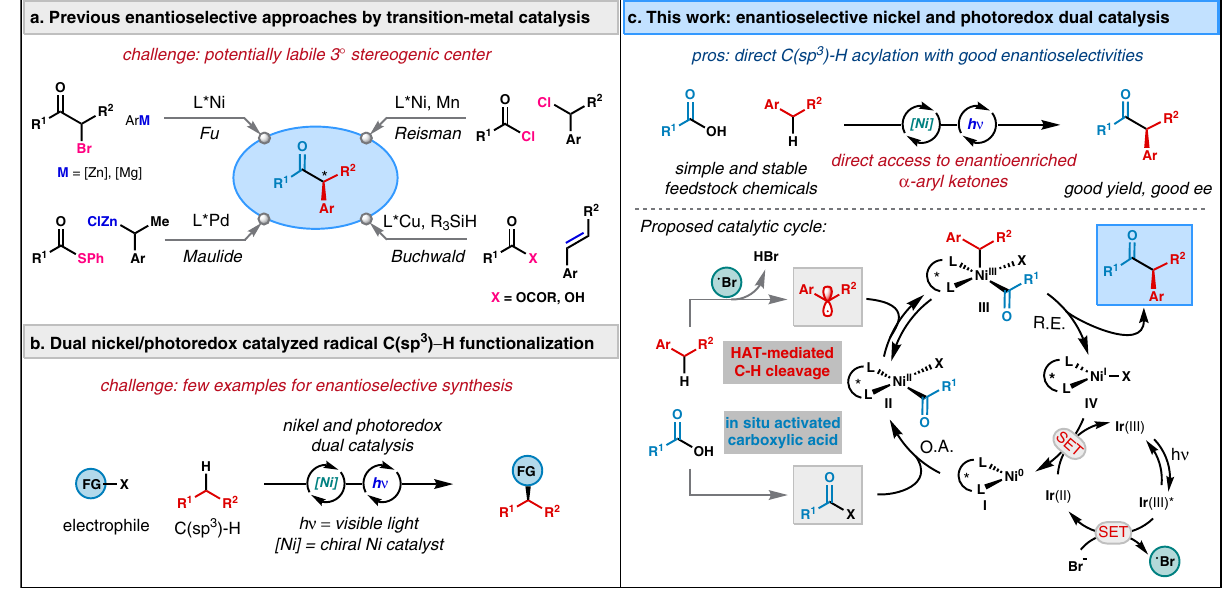
Fig. 1 Enantioselective metal-catalyzed approaches for the synthesis of α -aryl ketones. a Previous approaches. b Dual nickel/photoredox catalyzed C(sp 3 ) − H functionalization. c This work and its mechanistic hypothesis. O. A. oxidative addition, R. E. reductive elimination. Ir(III) = Ir[dF(CF